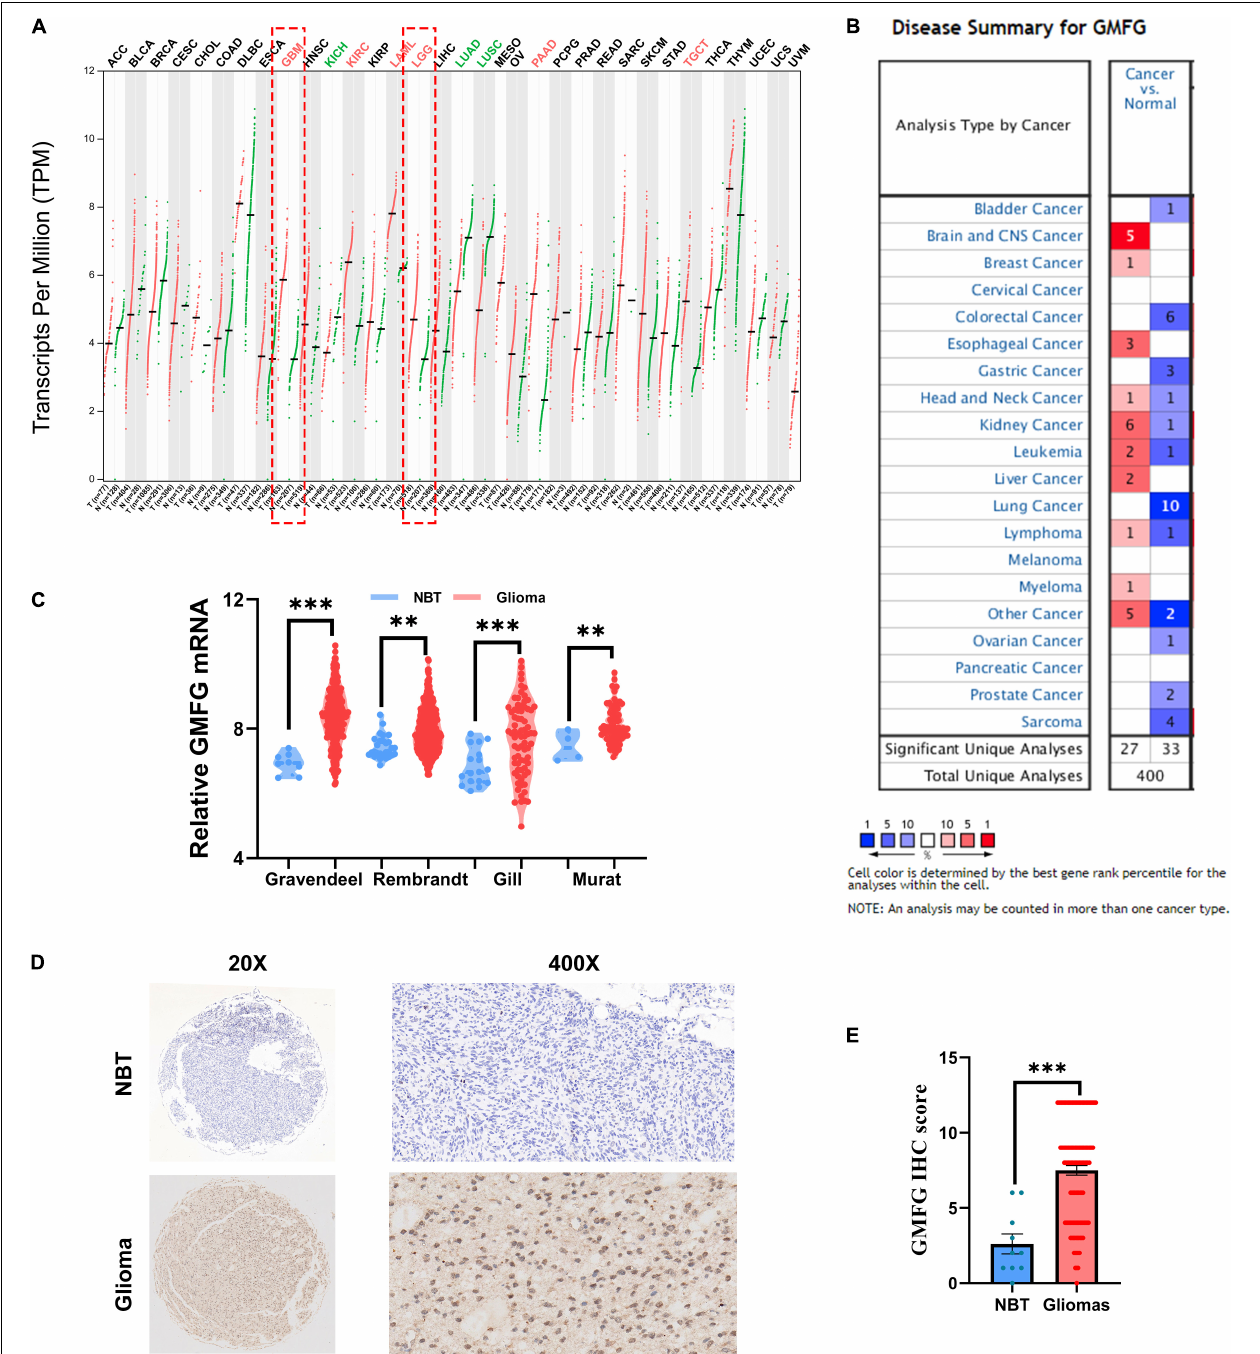
FIGURE 1 | Glia maturation factor- γ (GMFG) expression in gliomas. (A) Transcripts of GMFG in pan-cancers in the GEPIA platform; (B) alterations to mRNA and protein levels of GMFG in different types of cancers in Oncomine; (C) relative mRNA level of GMFG in non-tumor brain tissues (NBT) and gliomas tissues from Gravendeel, Rembrandt, Gill, and Murat datasets; (D,E) immunohistochemistry (IHC) staining of GMFG in NBT and gliomas tissues. ∗∗ P < 0.01, ∗∗∗ P < 0.001, ns, no significance.